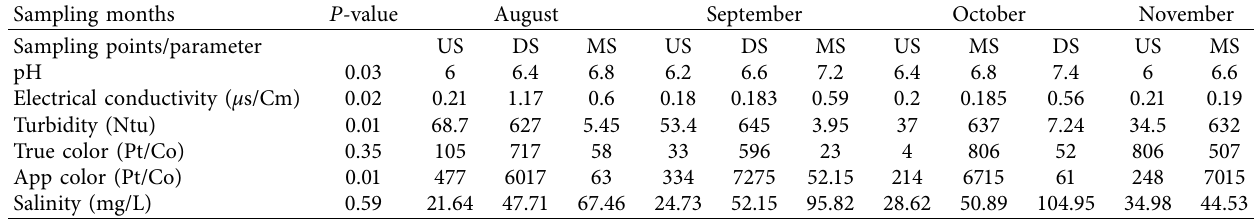
Table 3: Results of the various physicochemical parameters measured.